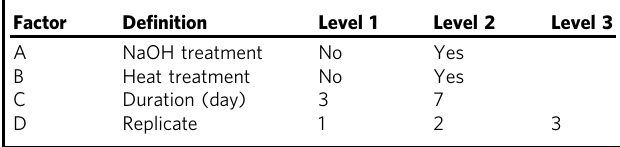
Table 1 Statistical design of experiments testing four titanium surfaces with SBF in static conditions